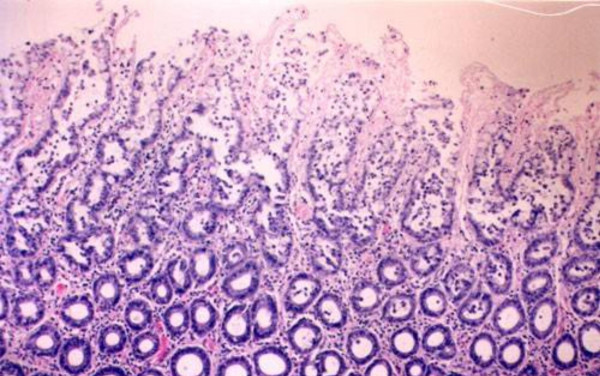
Mucosal ulceration, and necrosis with invasion of muscularis propria in group IV rats (Grade V) (HE, ×100).